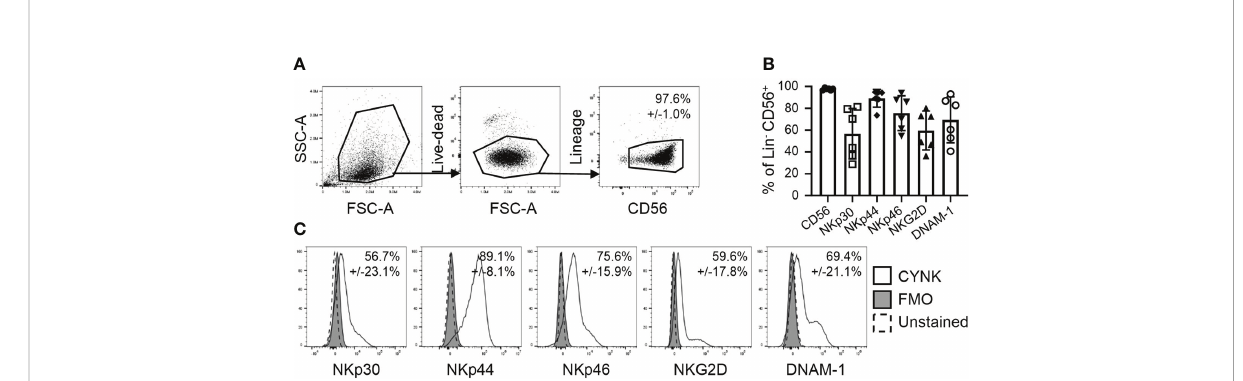
FIGURE 1 CYNK cells express NK cell activating receptors involved in virus recognition. (A) Representative fl ow cytometry dot plots demonstrating the gating strategy for the analysis of CYNK cells. Thawed CYNK cells were stained with fl uorophore-conjugated antibodies recognizing indicated NK cell markers and analyzed by fl ow cytometry. Lineage included CD3, CD14 and CD19. CYNK are de fi ned as live CD3 - CD14 - CD19 - CD56 + cells. (B) Proportion of indicated marker expression on CYNK cells. (C) Representative histograms of the expression of indicated NK activating cell receptors on CYNK cells. mean ± SD (n = 6) FMO - fl uorescence minus